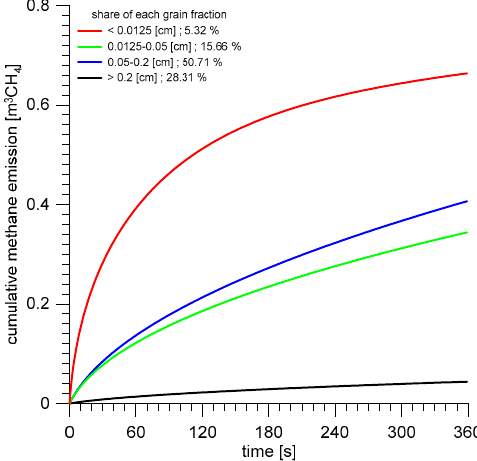
Figure 13. Methane emission in the first 6 s of the outburst from narrowed grain fractions—Budryk coal mine.